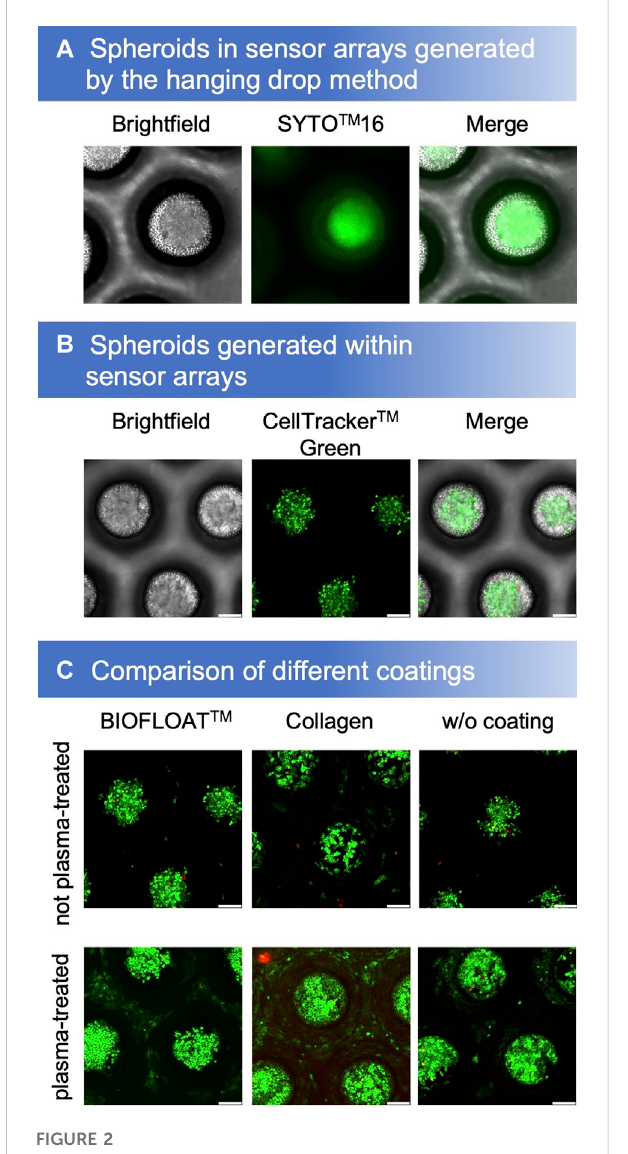
FIGURE 2 (A) Spheroids, stained with Syto ™ 16 and propidium iodide, generated by the hanging drop method could be cultivated in sensor microcavity arrays. (B) Another method is to generate spheroids directly in the sensor microcavity array (stained with CellTracker ™ green and propidium iodide after 4 days of cultivation). (C) Proliferation and aggregation comparison of different SF-RPC3 sensor fi lm coating methods.